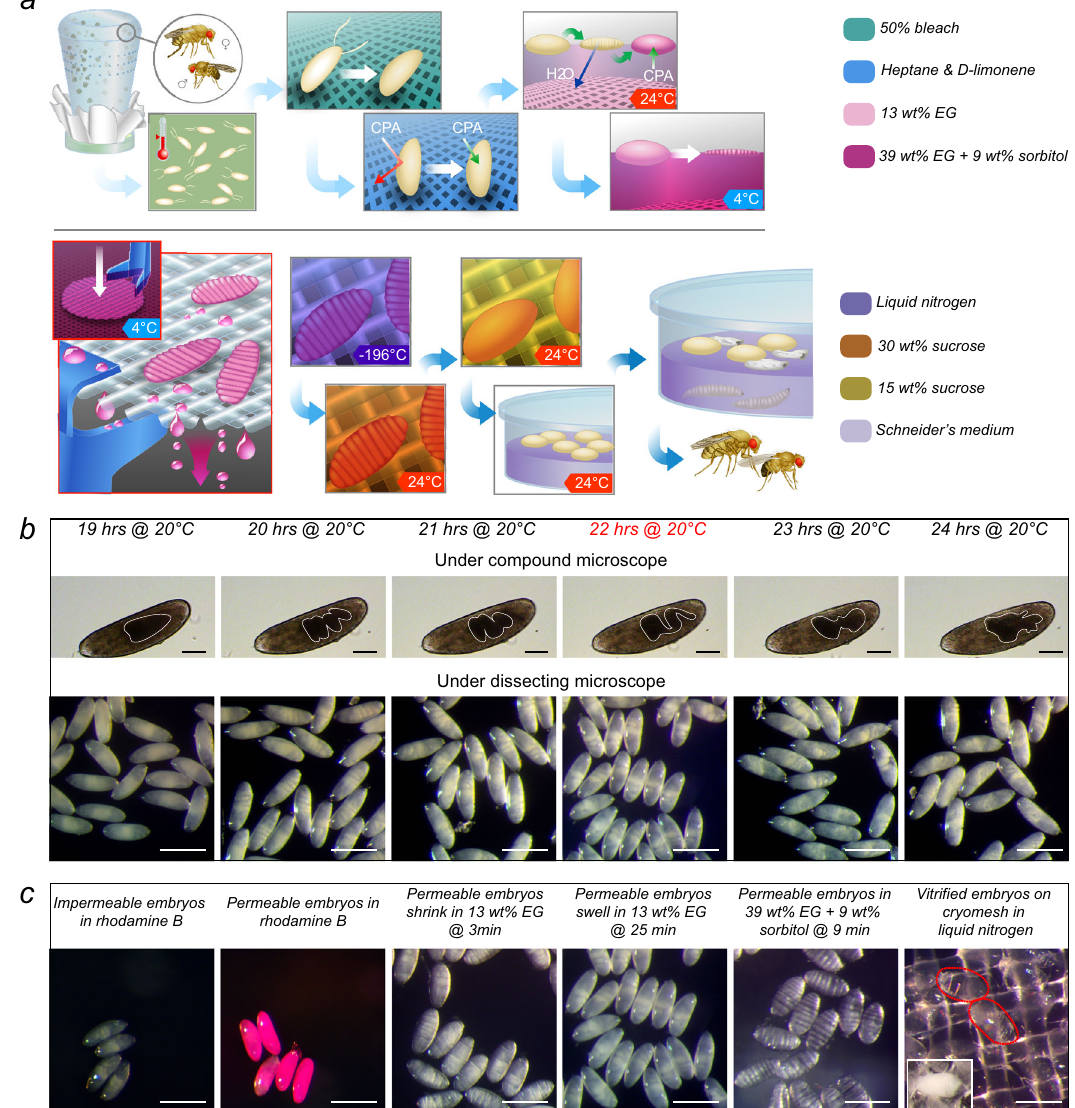
Fig. 1 Schematic overview of cryopreservation procedures for Drosophila melanogaster embryos and detailed pictorial illustration for critical steps. a On day 1, embryos were collected on a grape juice plate for 1 h period at room temperature (24 °C), then placed in a 20 °C incubator until reaching the desired stage for cryopreservation. On day 2, embryos were fi rst dechorionated and permeabilized, followed by CPA loading and dehydration. The cryomesh was used to pick up the dehydrated embryos for vitri fi cation, storage, rewarming, and CPA unloading. Afterward, embryos were cultured in Schneider ’ s medium overnight. On day 3, hatched larvae were transferred to food vials until adult emergence. b Images of embryo gut morphology under dissecting and compound microscopes after different incubation time at 20 °C. c Images of embryos at different steps during cryopreservation. From left to right, impermeable and permeable embryos after 5 min in 0.1% rhodamine B; permeable embryos fi rst shrunk then swelled in 13 wt% EG; fl attened embryos after dehydration; vitri fi ed embryos appeared transparent in LN 2 (two of them were outlined in red), inset is a crystallized embryo (i.e., failure). Five experiments were repeated independently with similar results for ( b – c ). Scale bars in compound microscope images are 100 μ m, in dissecting microscope images are 500 μ